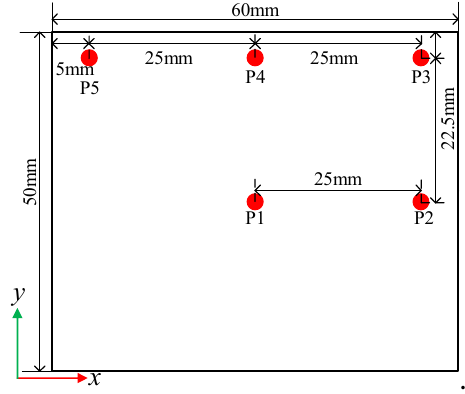
. Figure 9. The specific locations of the five points (7.5 mm from the top Figure 9. The specific locations of the five points (7.5 mm from the top surface). Table 2. Total computation time and standard deviation ( SD ) in different calculations at five locations.